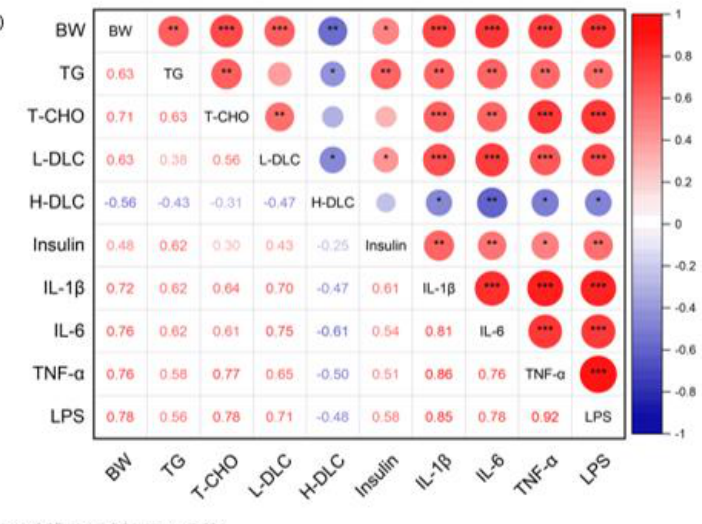
Figure 7. The anti-inflammation property of Torularhodin. Inflammatory cytokines IL- 1β ( A ), IL-6 ( B ), TNF- α ( C ), and LPS ( D ). HFD-T compared to control: * p < 0.05, *** p < 0.001; HFD-T compared to HFD: ### p < 0.001. The Pearson correlation matrix of phonotypic parameters ( E ): * p < 0.05, ** p < 0.01, *** p < 0.001.